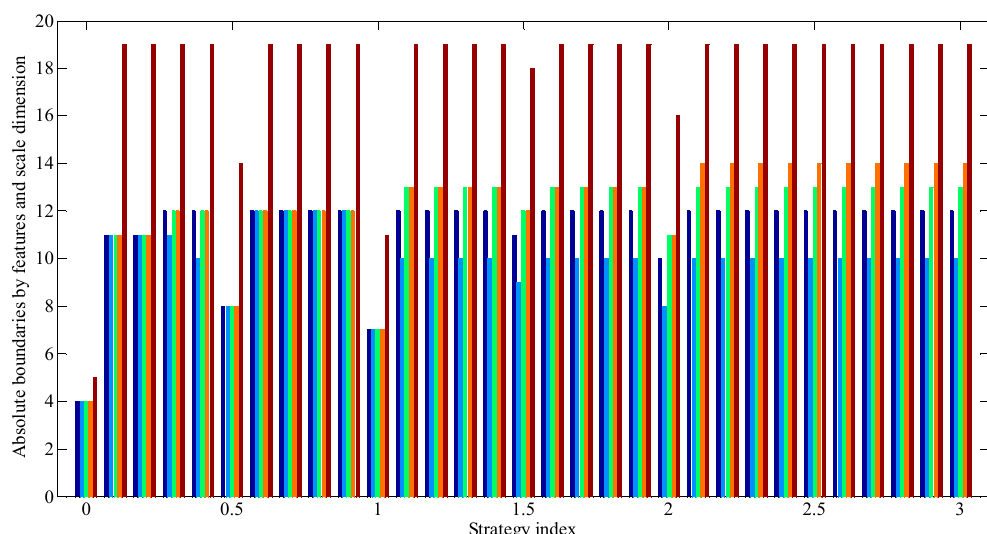
Figure 12. Diagram for the absolute boundaries of classes by assessment features in groups of rules and the dimension of the scale by feature.